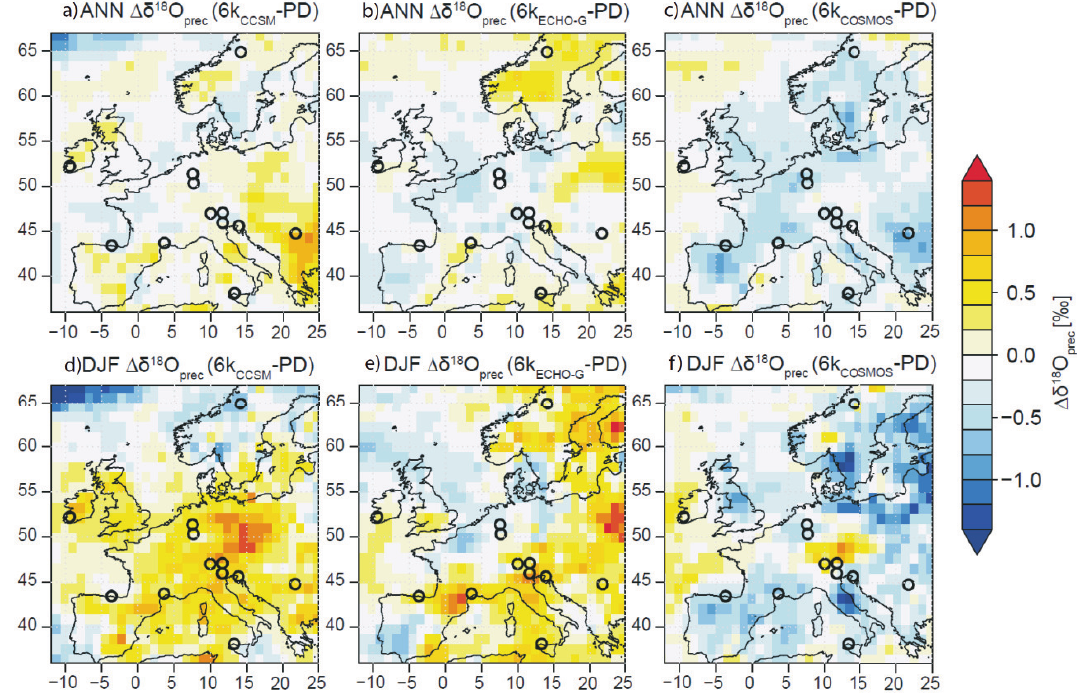
Fig. 5. As Fig. 3, but for δ 18 O prec anomalies (6k-PD) given relatively to VSMOW standard.